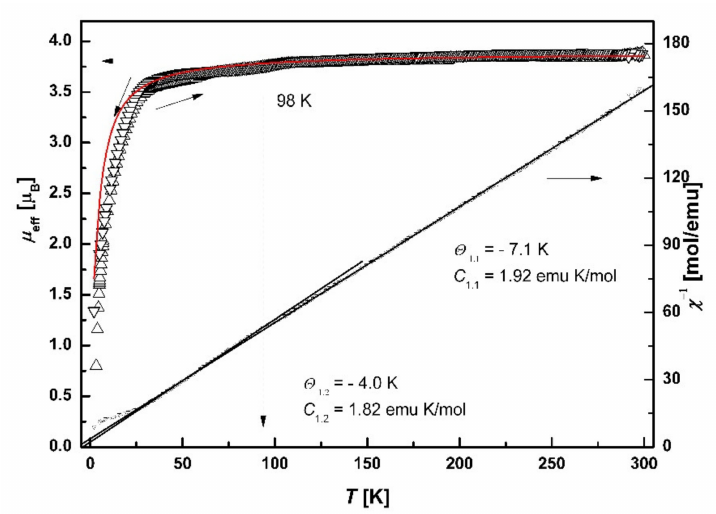
Figure 11. The temperature dependences of the effective magnetic moment, µ eff , and the inverse magnetic susceptibility, χ –1 , for 1 . Solid lines correspond to the Curie–Weiss fit with Θ 1.1 = − 7.1 K (110 < T < 300 K) and Θ 1.2 = − 4.0 K (30 < T < 90 K). The solid red line represents the best fit within the Bonner–Fisher model for LS and HS chains ( J 1LS = − 12.0 K, J 1HS = − 0.93 K), including PM contribution.